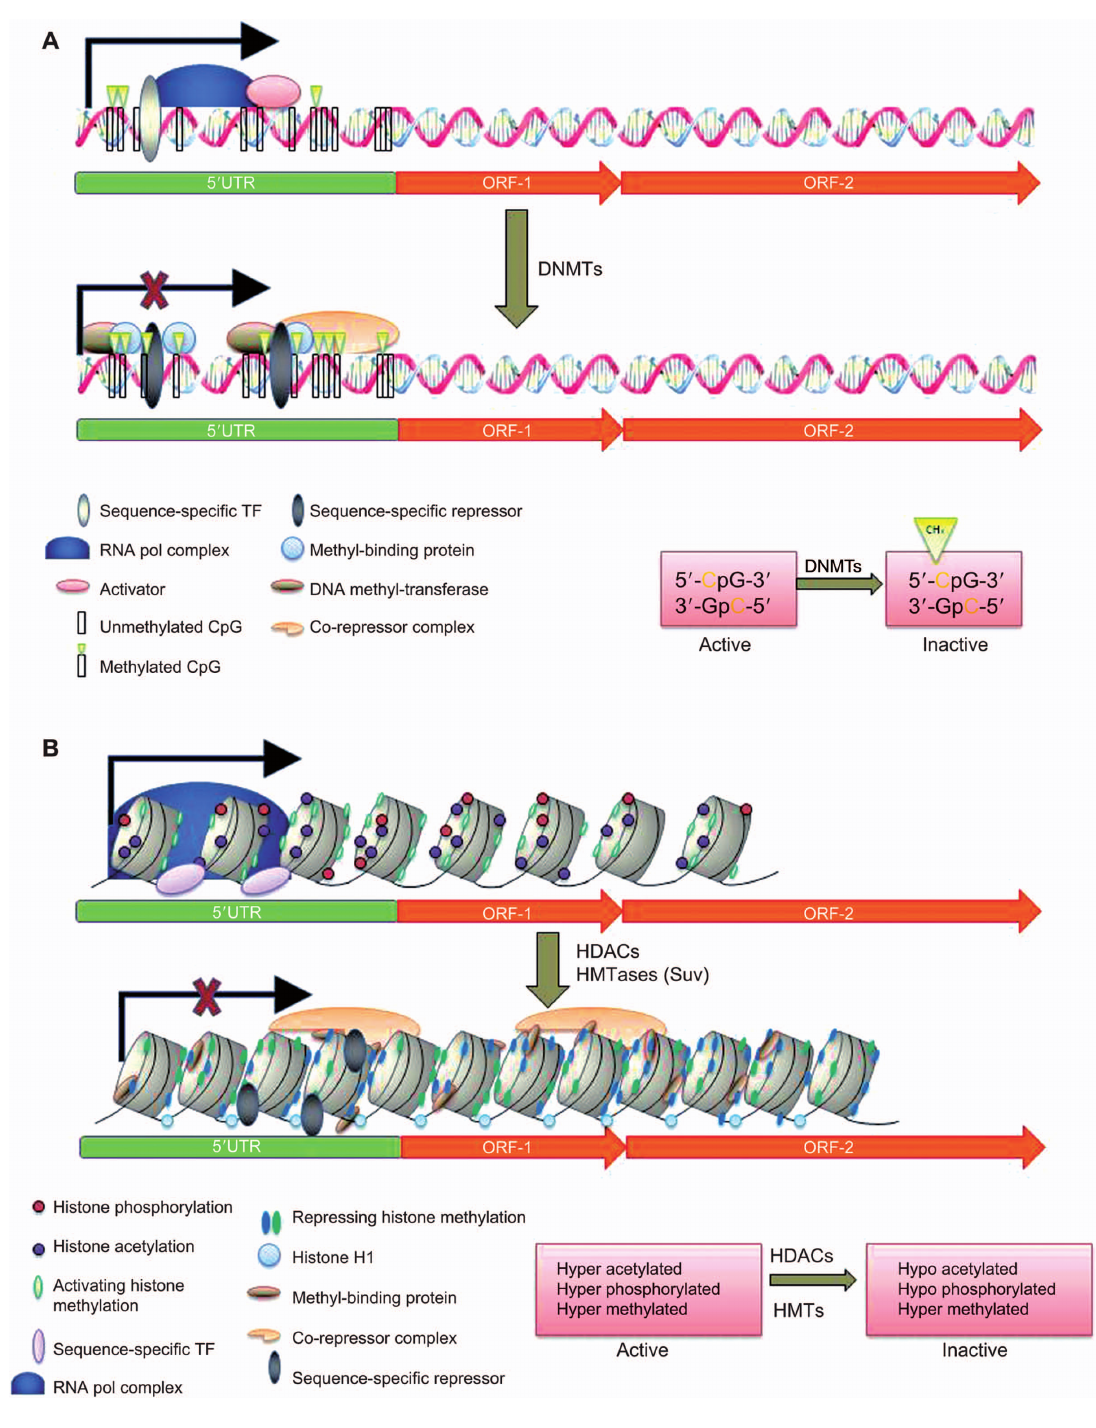
Figure 1 Epigenetic regulation of gene expression. Schematic representation of two epigenetic transcriptional control mechanisms: DNA methylation and nucleosomal histone modifications. (A) DNA methylation of CpG dinucleotides in CpG islands by DNA methyltransferases (DNMTs) leads to recruitment of transcription factors and accessory proteins involved in gene silencing and heterochromatin formation. The retinoblastoma transcription factor is able to repress transcription through direct recruitment of DNMT1. The L1 internal promoter (5 9 UTR) is subject to epigenetic control by E2F/RB and DNMTs (see text for details). (B) Epigenetic post-transcriptional modifications on nucleosomal histones lead to open or closed chromatin states responsible for activation or silencing of transcription, respectively. The retinoblastoma family of proteins interacts with both histone deacetylases (HDACs) and histone methyltransferases (HMTs) to silence chromatin leading to either facultative or constitutive heterochro- matin formation. The nucleosomal proteins associated with the L1 internal promoter (5 9 UTR) are subject to epigenetic control by E2F/RB and HDACs (see text for